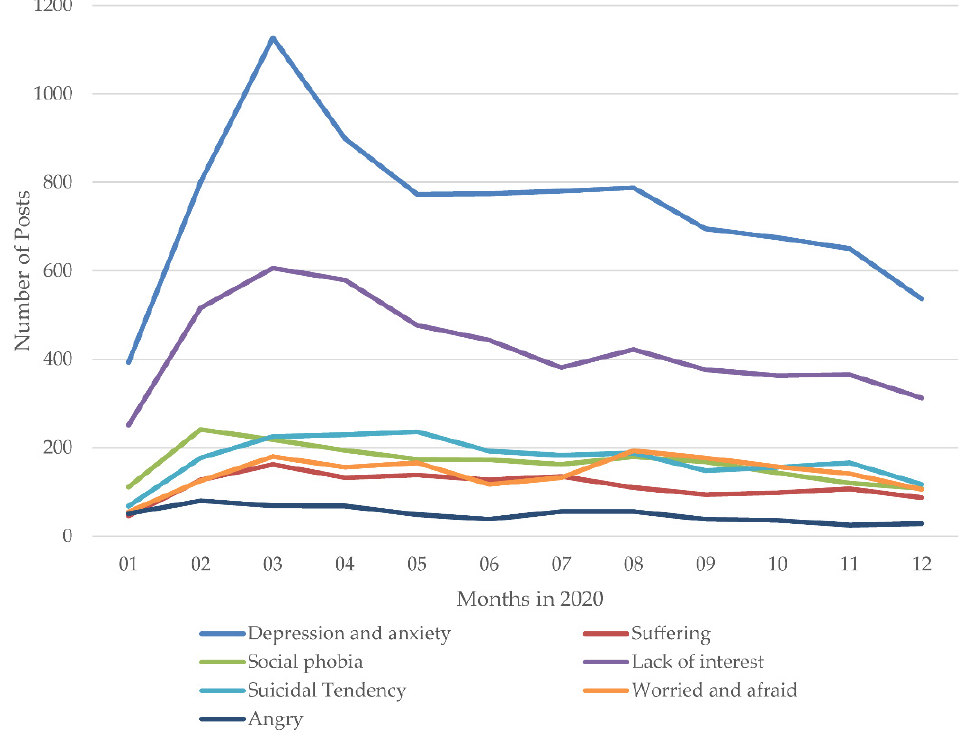
Figure 8. The monthly trends of the number of PHS posts related to psychological problems during the COVID-19 pandemic.